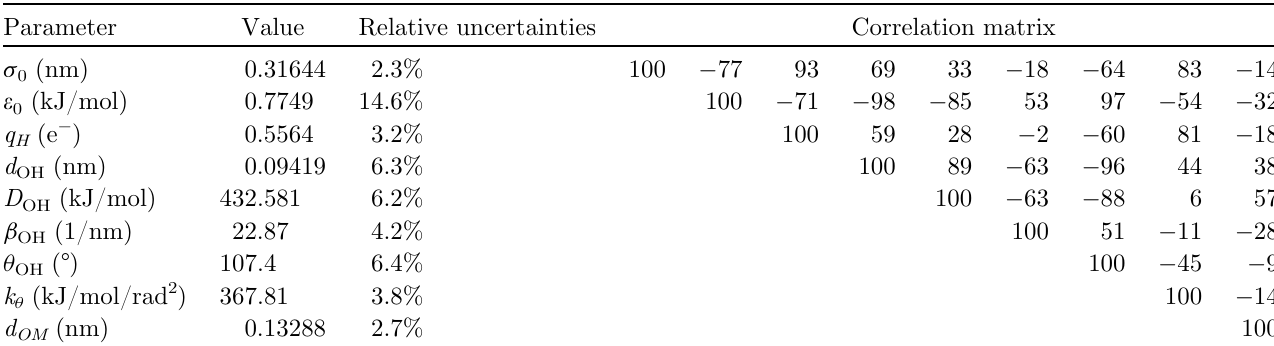
Table 5. Relative uncertainties and correlation matrix between the CAB model parameters after the marginalization. Parameter Value Relative uncertainties Correlation